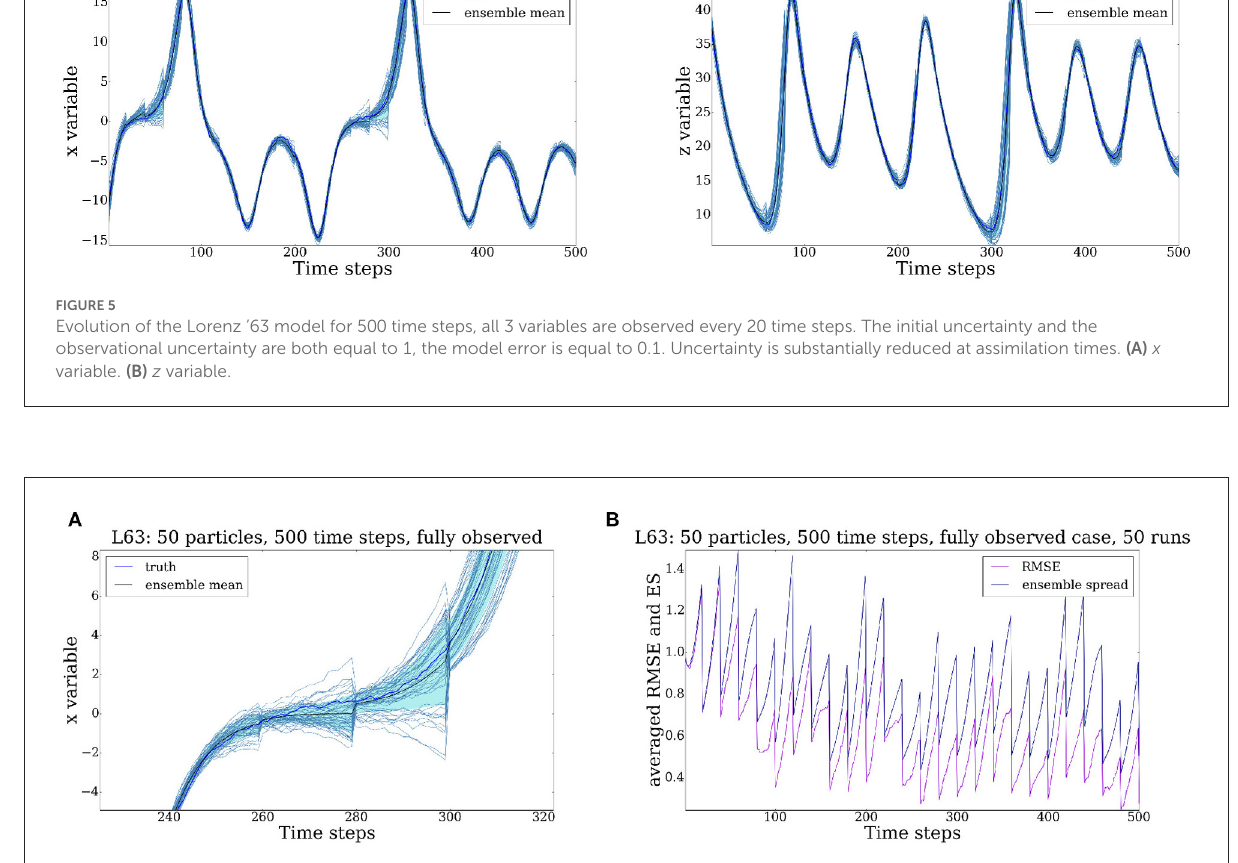
FIGURE6 Evolution of the Lorenz ’63 model for 500 time steps, all 3 variables are observed every 20 time steps. The initial uncertainty and the observational uncertainty are both equal to 1, the model error is equal to 0.1. Uncertainty is substantially reduced at assimilation times. (A) x variable enlarged. (B) RMSE and